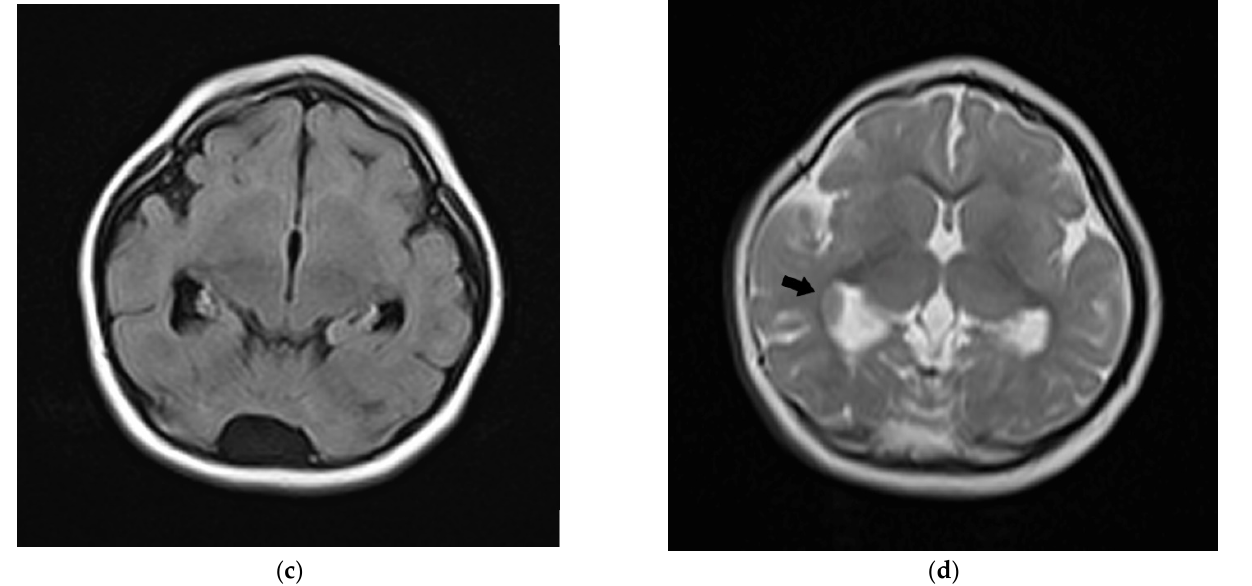
Figure 2. Brain MRI follow ‐ up at 2 years 1 month of age. ( a ) Spin echo T1, sagittal view: enlarged posterior fossa with large cisterna magna. ( b ) Inversion recovery, coronal view: posteriorly enlarged lateral ventricles. ( c ) Fluid ‐ attenuated inversion recovery, axial view: enlarged ventricles and fronto ‐ polar simplified gyral pattern. ( d ) Turbo spin echo T2, axial view: right periventricular nodular heterotopia (arrow).